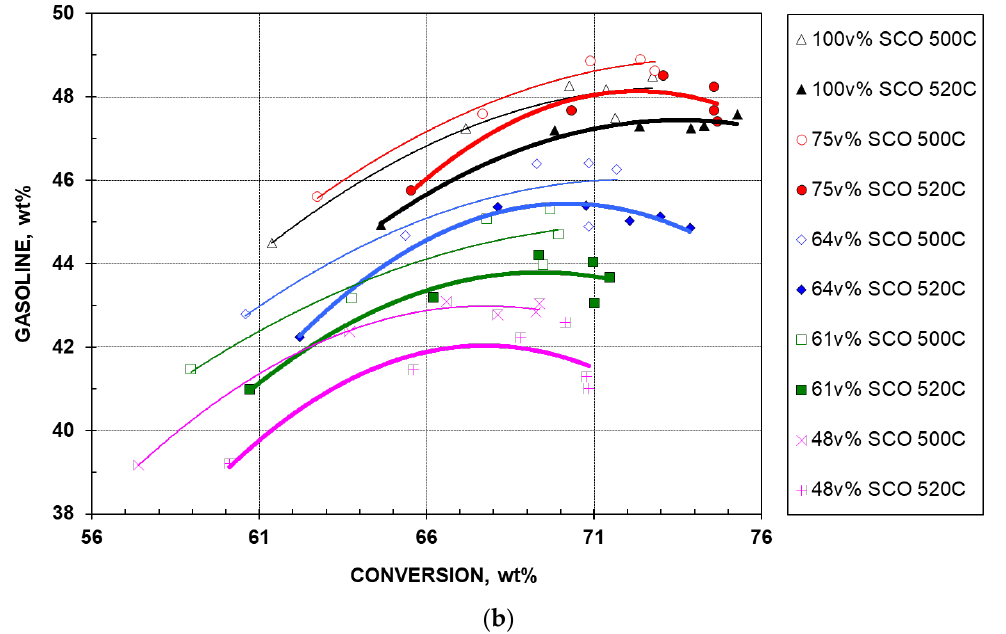
Figure 4. ( a ) Gasoline yield vs. C / O ratio at two reaction temperatures; ( b ) Gasoline yield vs. conversion at different reaction temperatures.